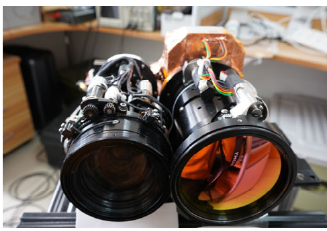
Figure 1. Visible/infrared dual-band fusion imaging system with continuous zoom.